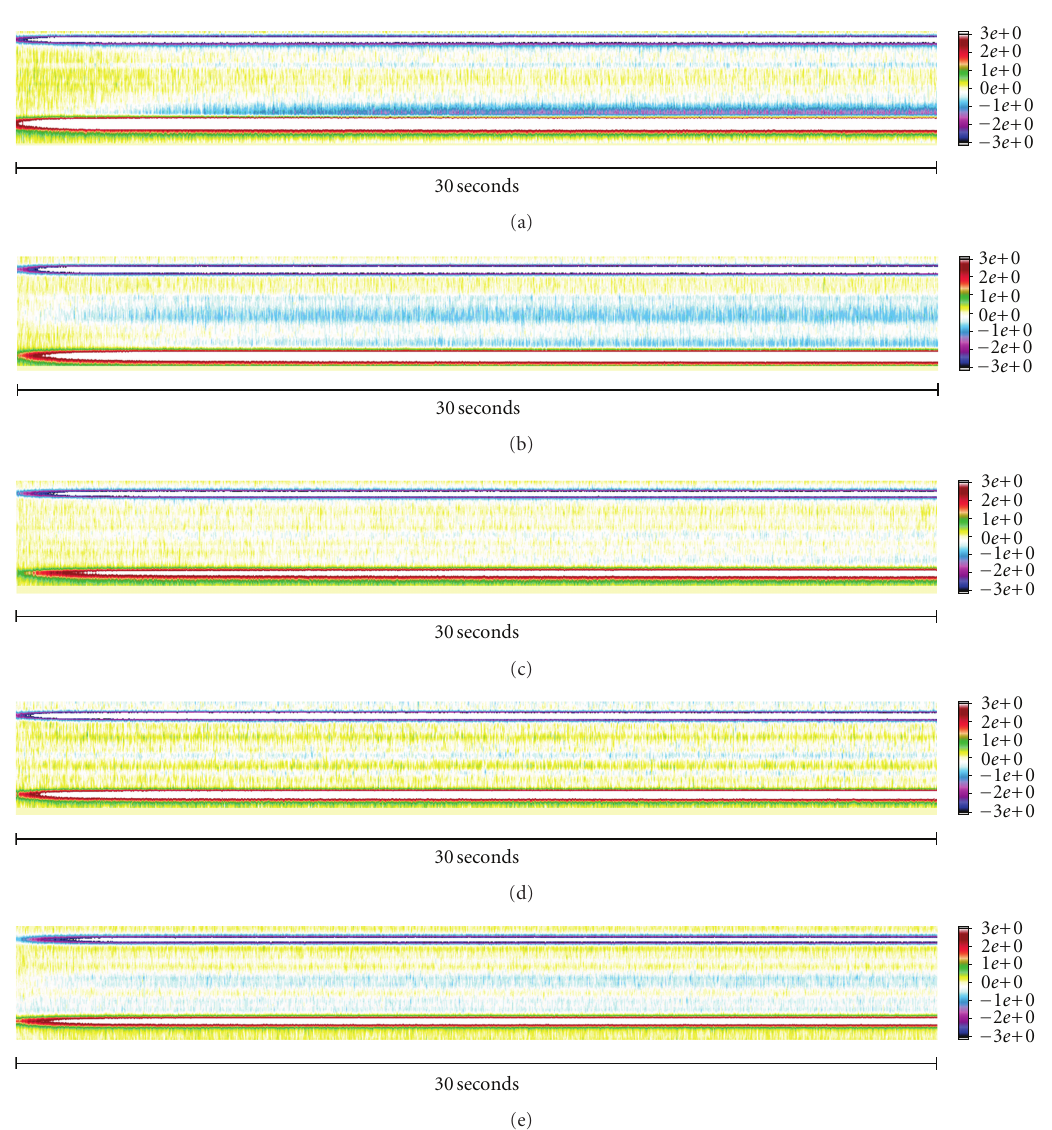
Figure 2: Charge patterns of specimens in the first 30 seconds of polarization. (a) No. 0, (b) no. 1, (c) no. 5, (d) no. 10, and (e) no.